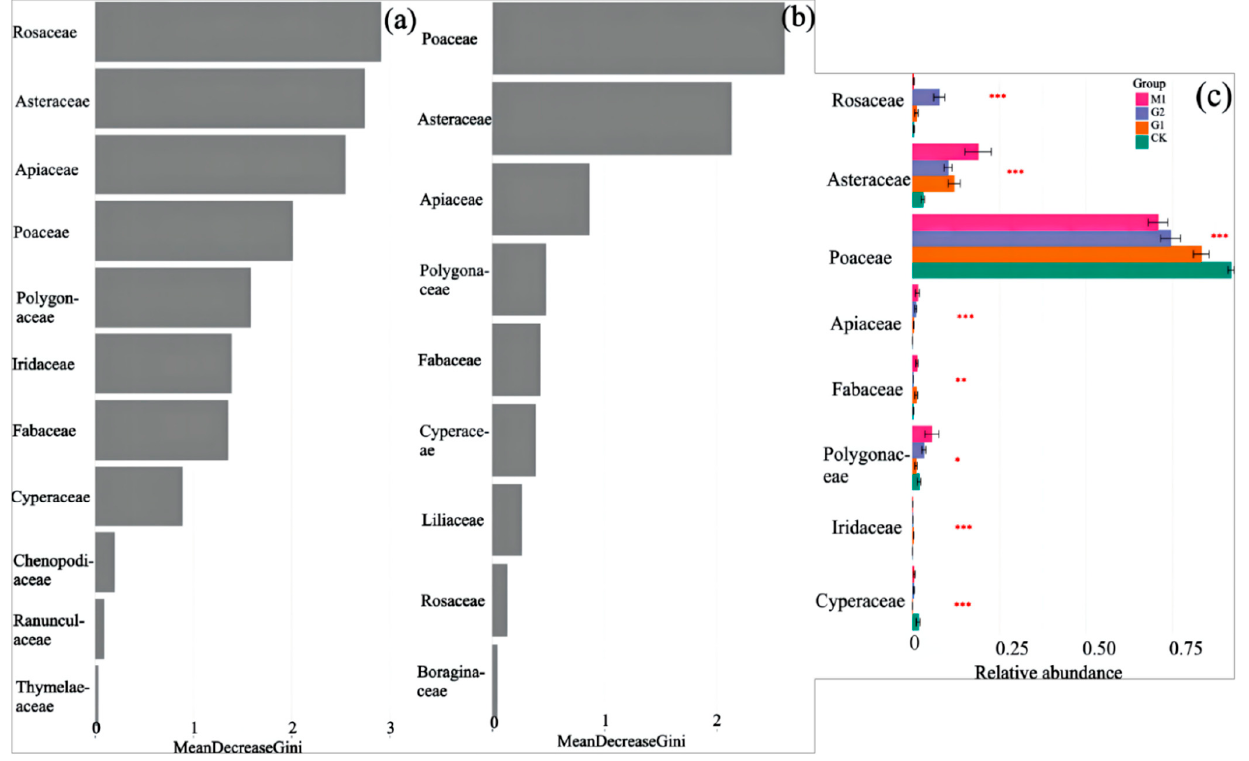
Figure 5. Predicting the pattern of grazing sheep and mowing grassland vegetation functional groups (family classification level) in context of nitrogen deposition based on a random forest model; ( a ) Mean decrease Gini values of plant functional groups in grazing sheep grasslands in the context of nitrogen deposition; ( b ) Mean decrease Gini values of plant functional groups in mowing grasslands in the context of nitrogen deposition; ( c ) Relative abundance of functional groups. Significant effects of treatments are marked with an asterisk. Single, double, and triple asterisks evaluate the significance levels at p < 0.5, <0.01 and <0.001, respectively.